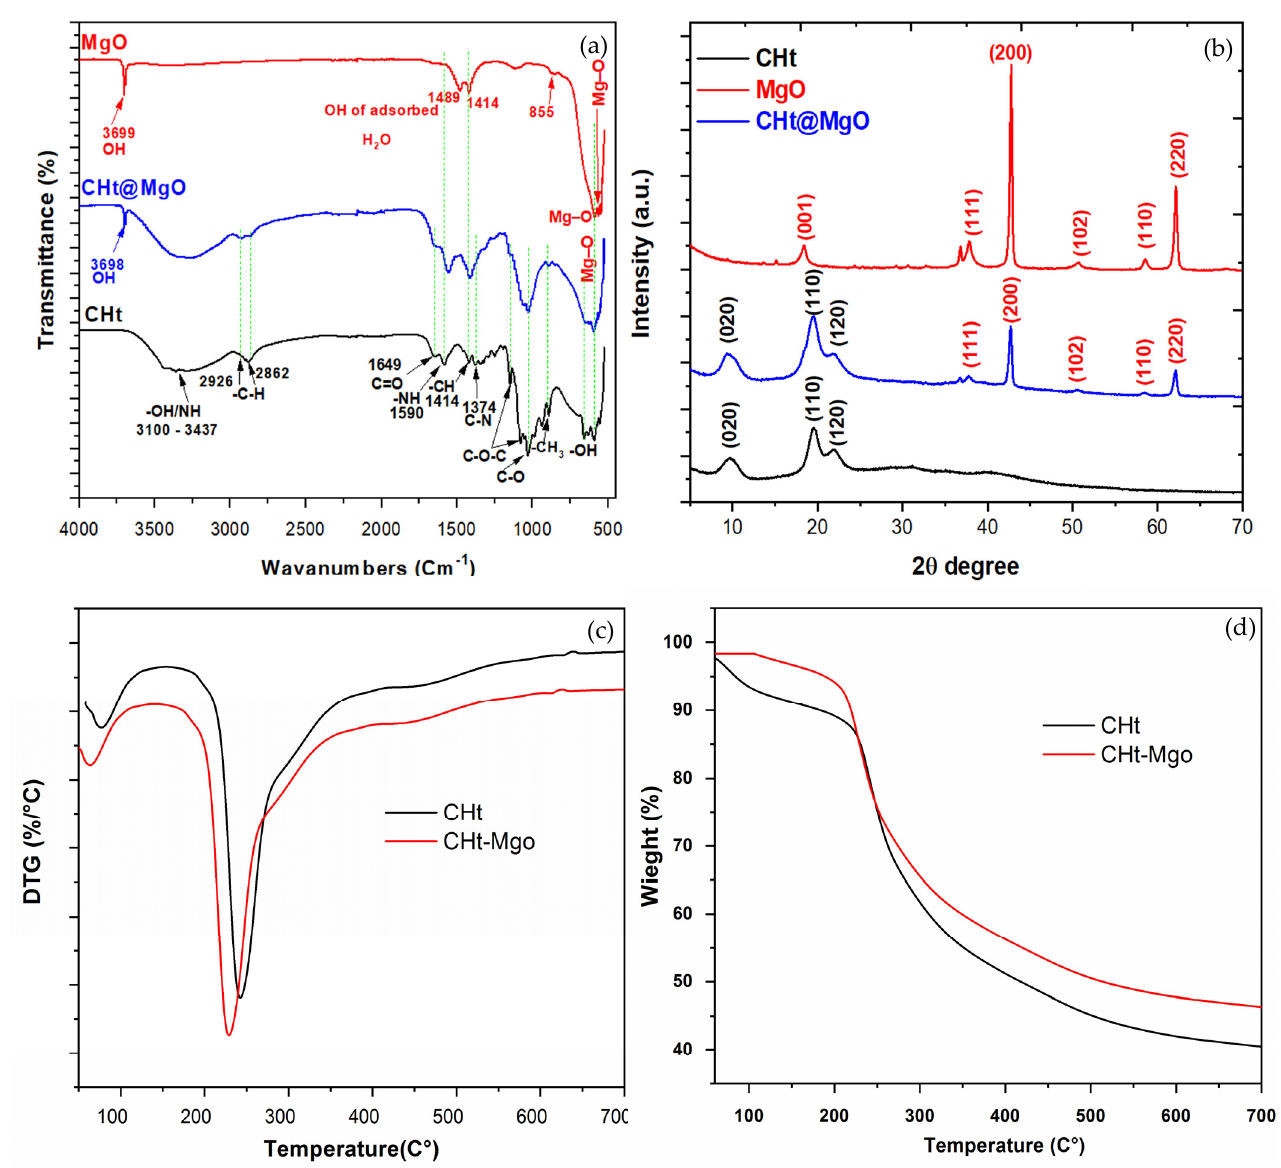
Figure 1. FT–IR spectra ( a ); XRD patterns ( b ); DTG curves ( c ) and TGA curves ( d ). Figure 1. FT – IR spectra ( a ); XRD patterns ( b ); DTG curves ( c ) and TGA curves ( d ). The thermogravimetric results (DTG/TGA) obtained for CHt and CHt@MgO com- posite are displayed in Figure 1 c and d, respectively. As can be observed in Figure 1c, the The X-ray diffraction (XRD) patterns of CHt, CHt@MgO, and MgO samples are pre- major decomposition peak of CHt@MgO occurred at a slightly lower temperature than that sented in Figure 1b. In the XRD pattern of CHt, three characteristic diffraction peaks at 2 θ = of CHt, but the percentage mass loss of the composite was lower than that of CHt, which 9.6°, 19.30°, and 21,95°, respectively corresponding to (0 2 0), (1 1 0), and (1 2 0) crystal may be related to the relatively high thermal stability of MgO [39]. Therefore, the total planes, were observed, which revealed the crystalline and amorphous structure [33] of mass loss was 60% and 54% for CHt and the CHt@MgO composite, respectively (Figure 1d). CHt, in agreement with previously reported results [38]. The diffraction peaks of CHt were The thermal decomposition profile of CHt exhibited three stages of mass loss (Figure 1c,d). present in the XRD pattern of CHt@MgO, along with new diffraction peaks at 2 θ = 37.76° (1 During the first stage, ~6% mass loss arose in the temperature range 30–100 ◦ C owing to 1 1), 42.73° (2 0 0), 58.45° (1 1 0), 50.5° (1 0 2), and 62.13° (2 2 0), which matched the cubic the loss of surface-absorbed moisture. The second stage of mass loss (~7%), in the range of lattice of MgO reported in the literature [28]. The pure MgO diffraction peaks appeared at 190–400 ◦ C and peaking at 250 ◦ C, was due to the decomposition of functional groups of 2 θ = 18.50°, 37.76°, 42.73°, 58.45°, 50.5°, and 62.13°, as attributed to (0 0 1), (1 1 1), (2 0 0), (1 1 CHt. The third stage of mass loss (~47%) occurred in the temperature range of 430–700 ◦ C, 0), (1 0 2), and (2 2 0) planes of MgO [37]. Compositing with CHt shielded the MgO peak which may be attributed to the degradation of the saccharide ring of CHt [40,41]. The DTG intensities. Thus, low-intensity MgO peaks were observed in CHt@MgO patterns. and TGA curves of CHt@MgO biocomposite also showed thermal decomposition in three stages (Figure 1c,d). The first stage of mass loss (~2%) occurred at <100 ◦ C, which may be assigned to the loss of water [42]. The second and third stages involved mass